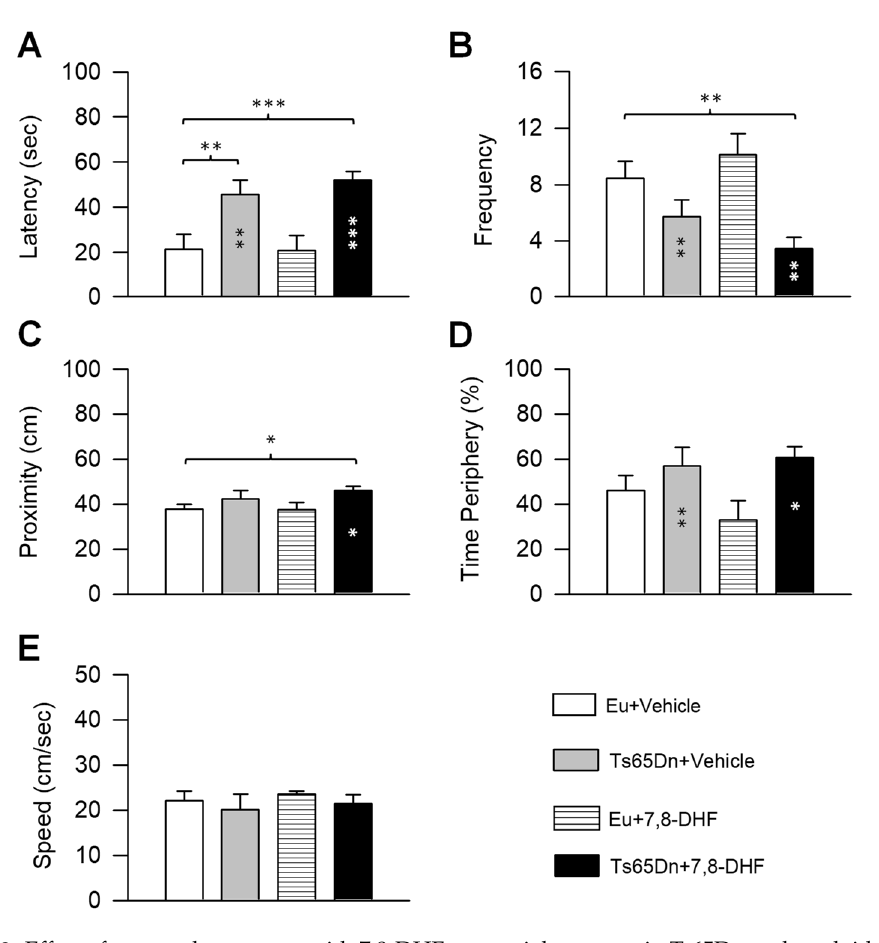
Figure 3. E ff ect of neonatal treatment with 7,8-DHF on spatial memory in Ts65Dn and euploid mice. Memory was assessed in the probe test as latency to reach the former platform zone ( A ), frequency of crossings over the former platform quadrant ( B ), proximity to the former platform zone ( C ), percentage of time spent at the periphery ( D ) (same mice as in Figure 2). ( E ): Swimming speed during the probe test. Values are mean ± SE. * p ≤ 0.05; ** p ≤ 0.01; *** p ≤ 0.001 (Fisher LSD test after ANOVA). Black asterisks in the gray bar indicate a di ff erence between untreated Ts65Dn mice and treated euploid mice; white asterisks in the black bar indicate a di ff erence between treated Ts65Dn mice and treated euploid mice. Abbreviations: 7,8-DHF, 7,8-dihydroxyflavone; cm, centimeters; Eu, euploid; sec, seconds.